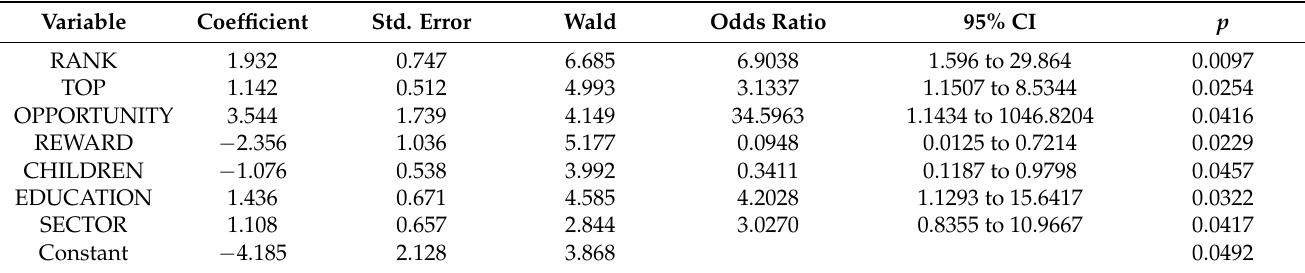
Table 7. Logistic regression